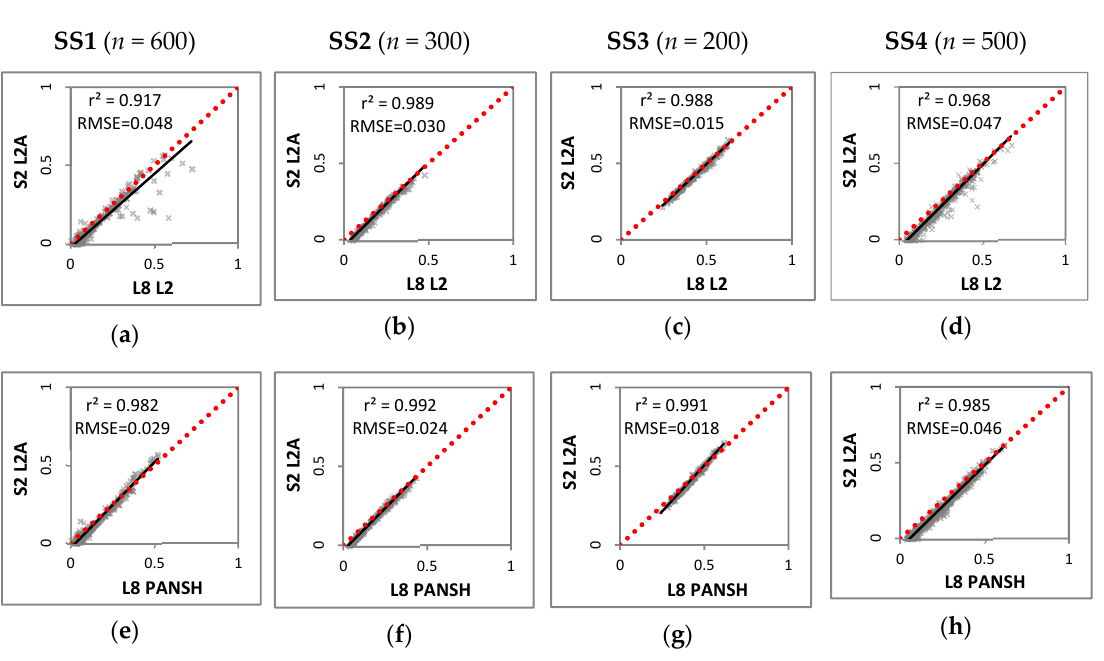
Figure 8. Scatterplots relating pairs (S2 vs. L8) of NDVI values for each study site, with n being the number of total data points: ( a ) L8 L2 vs. S2 L2A for SS1; ( b ) L8 L2 vs. S2 L2A for SS2; ( c ) L8 L2 vs. S2 L2A for SS3; ( d ) L8 L2 vs. S2 L2A for SS4; ( e ) L8 PANSH vs. S2 L2A for SS1; ( f ) L8 PANSH vs. S2 L2A for SS2; ( g ) L8 PANSH vs. S2 L2A for SS3; ( h ) L8 PANSH vs. S2 L2A for SS4.